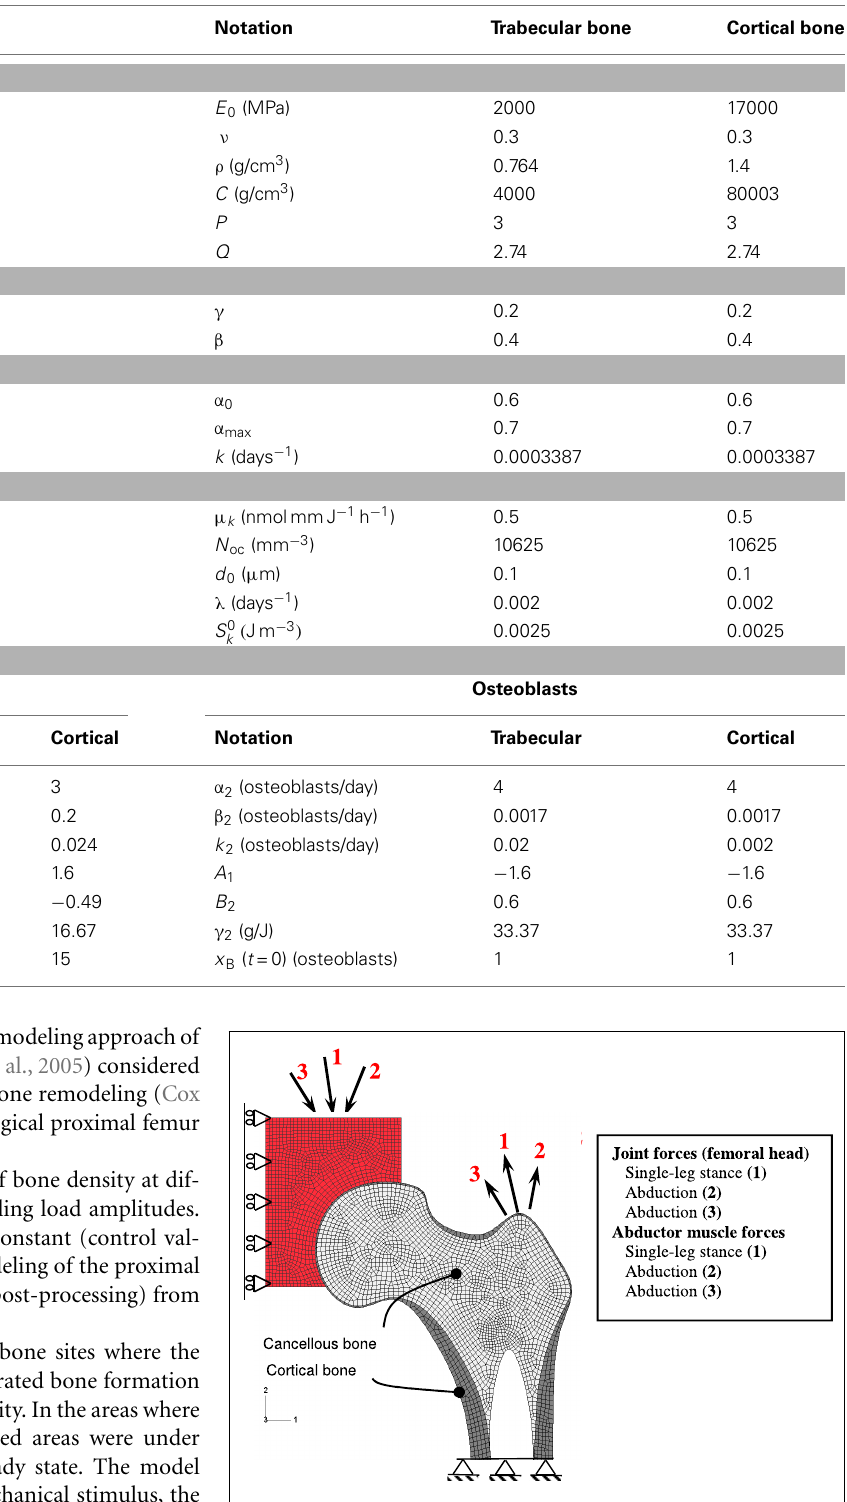
FIGURE 2 | FE of the proximal femur and boundary conditions